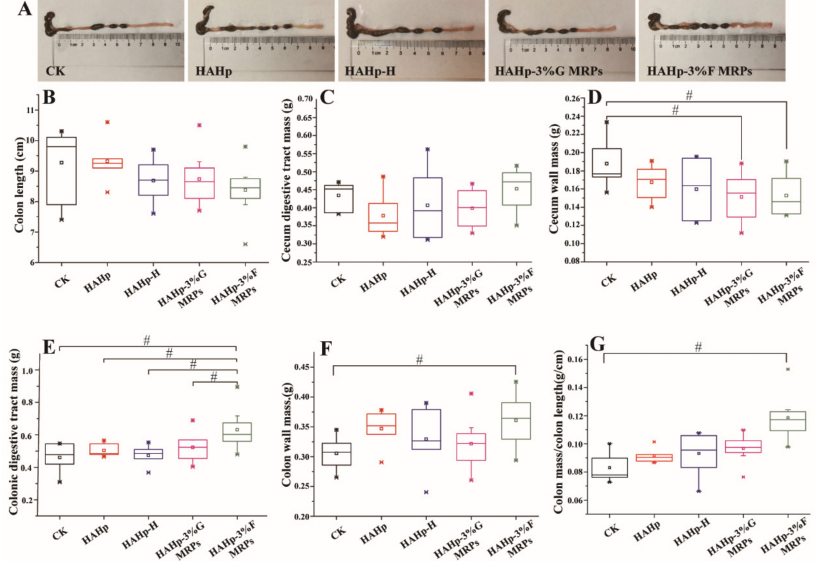
Figure 3. Cecum colonic intestinal environment of mice in the CK, HAHp, HAHp-H, HAHp-3%G MRPs, and HAHp-3%F MRPs groups after 30 days of oral gavage. ( A ) Intestinal photograph; ( B ) colon length, ( C ) cecum digestive tract mass; ( D ) cecum wall mass; ( E ) colonic digestive tract mass; ( F ) colon wall mass, and ( G ) ratio of colon mass/colon length. Data are expressed as the mean ± standard deviation ( n = 7). # represents 0.01 < p < 0.05 vs. the CK